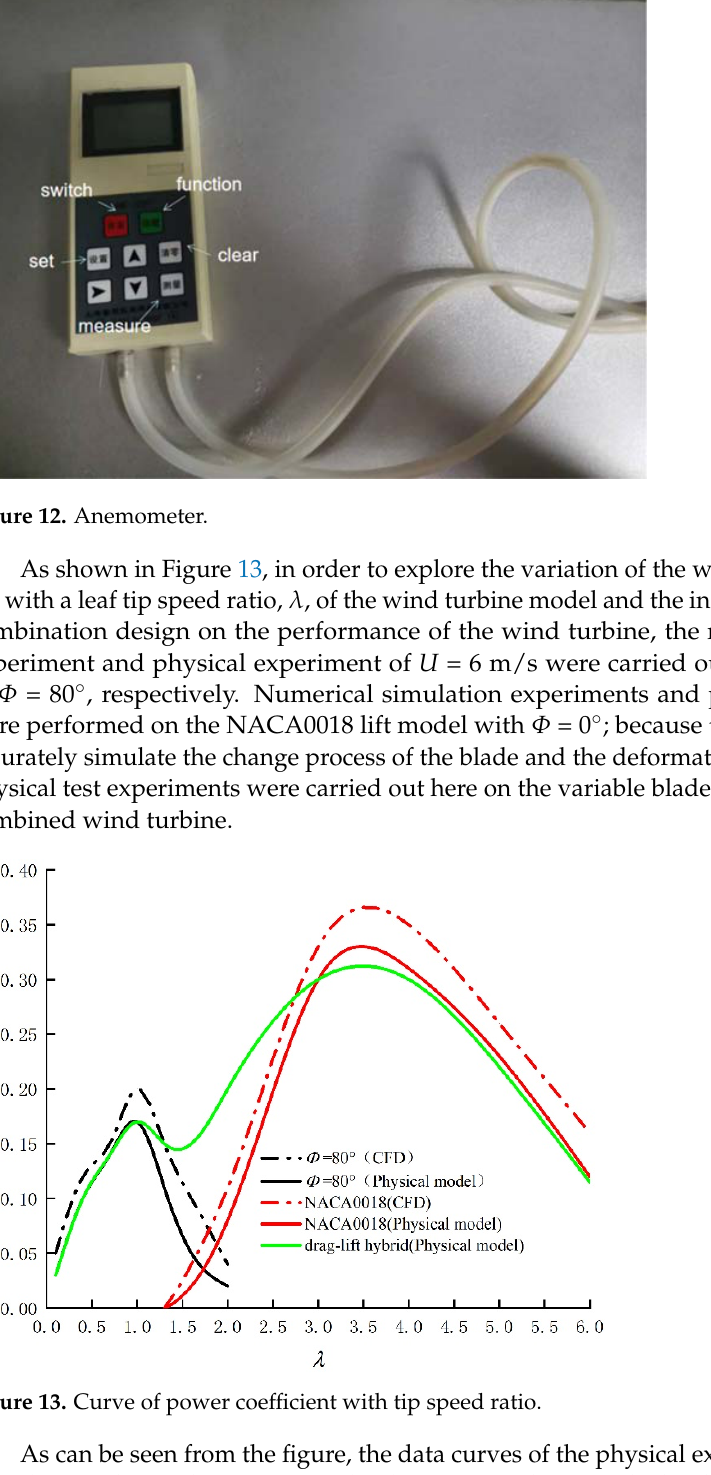
L-type pitot tube and with a working pressure range of − 2000~+2000 Pa, a wind speed measurement range of 0.40~30.00 m/s, a maximum overload capacity of 200%, and an error rate of 1%. It can bear a maximum temperature of 800 ◦ and has a weight of 0.3 kg.